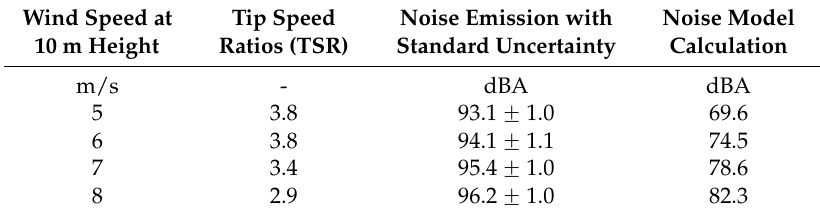
Table 2. Noise emission for different wind speeds calculated from results of recordings.